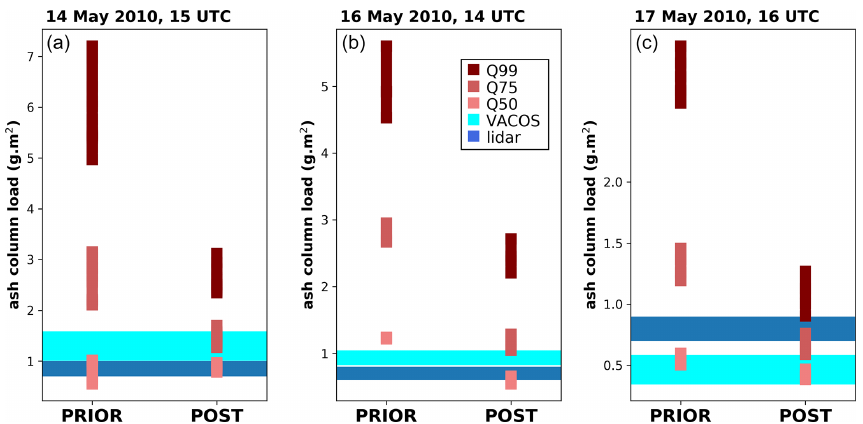
Figure 9. Comparison of ash load (vertical axis, unit gm − 2 ), for the a priori (PRIOR) and a posteriori (POST) ensembles (abscissa), at the location of lidar measurements shown in Fig. 3, on 14 May at 15:00UTC (a) , on 16 May at 14:00UTC (b) , and on 17 May at 16:00UTC (c) . The range of lidar, or VACOS, estimates along the flight track are plotted as blue, or light blue, horizontal rectangles. Note that, in these cases, lidar and VACOS values do not overlap. The different quantiles ( Q 50, Q 75, Q 99) are plotted as different red tones: the darker the colour, the higher the quantiles. For all data, the values of several grid points are plotted that sample the column loads along the flight track. Note the different y -axis